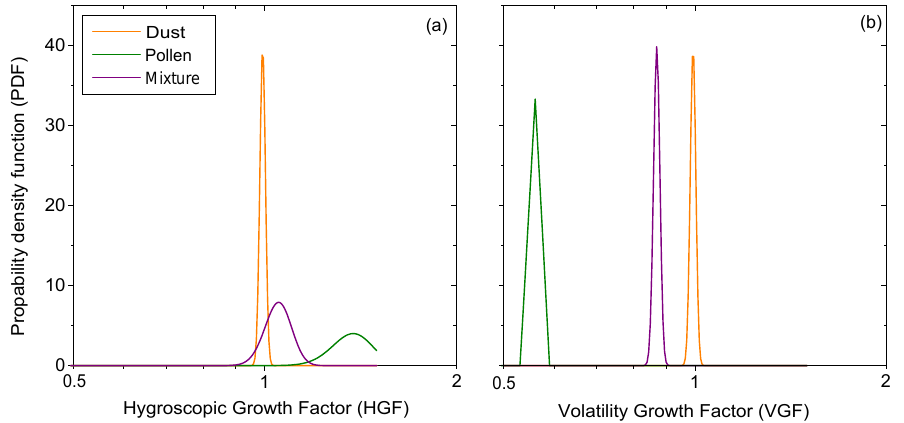
Figure 2. (a) Probability density function (PDF) of the hygroscopic growth factor (HGF) determined from the VH-TDMA measurements at 90% relative humidity. (b) PDF of the volatile “growth” factor (VGF) determined from the VH-TDMA measurements at 300 ◦ C.